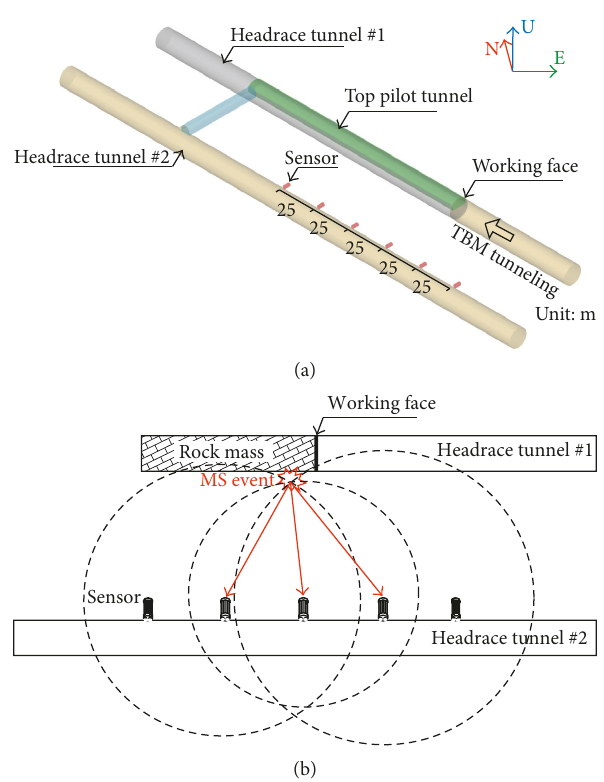
Figure 11: (a) The layout scheme and (b) source location mode of the neighbour sensor